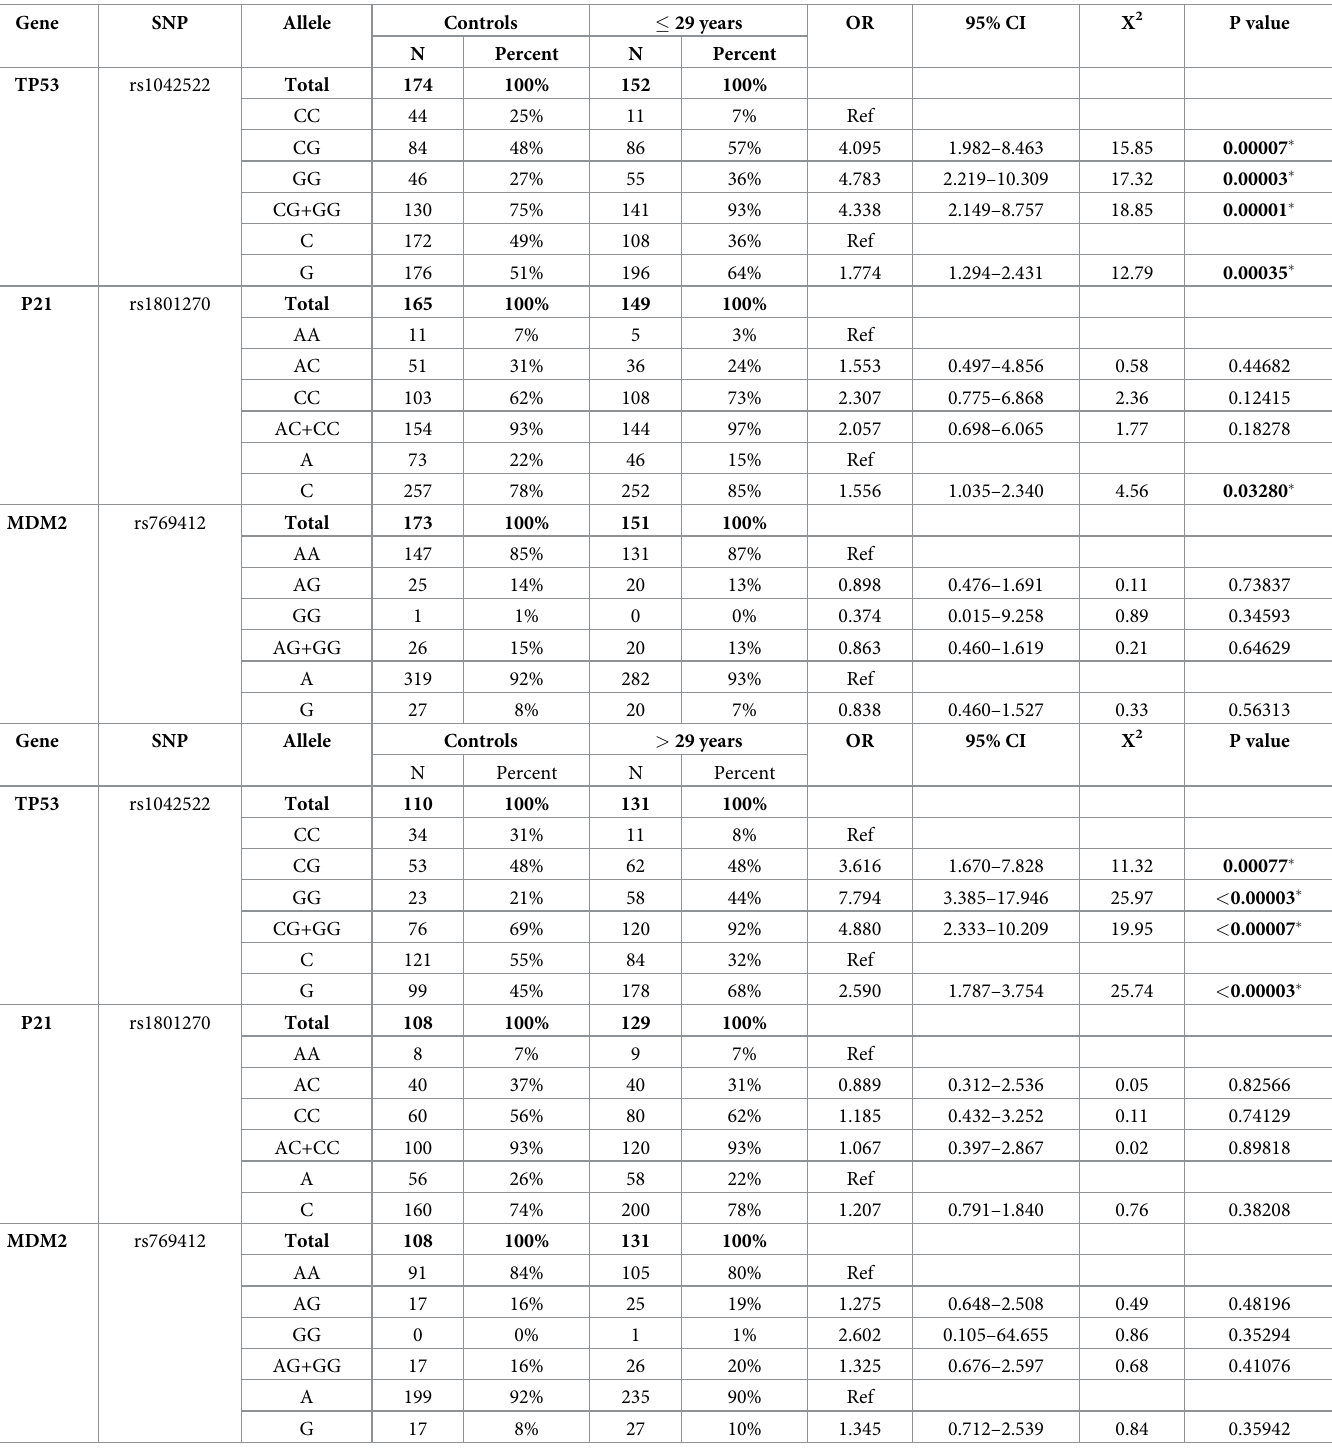
Table 3. Comparison of genotype distributions of P53, P21, and MDM2 gene polymorphisms between smokers aged � 29 years and > 29 years and their correspond- ing controls. Gene SNP